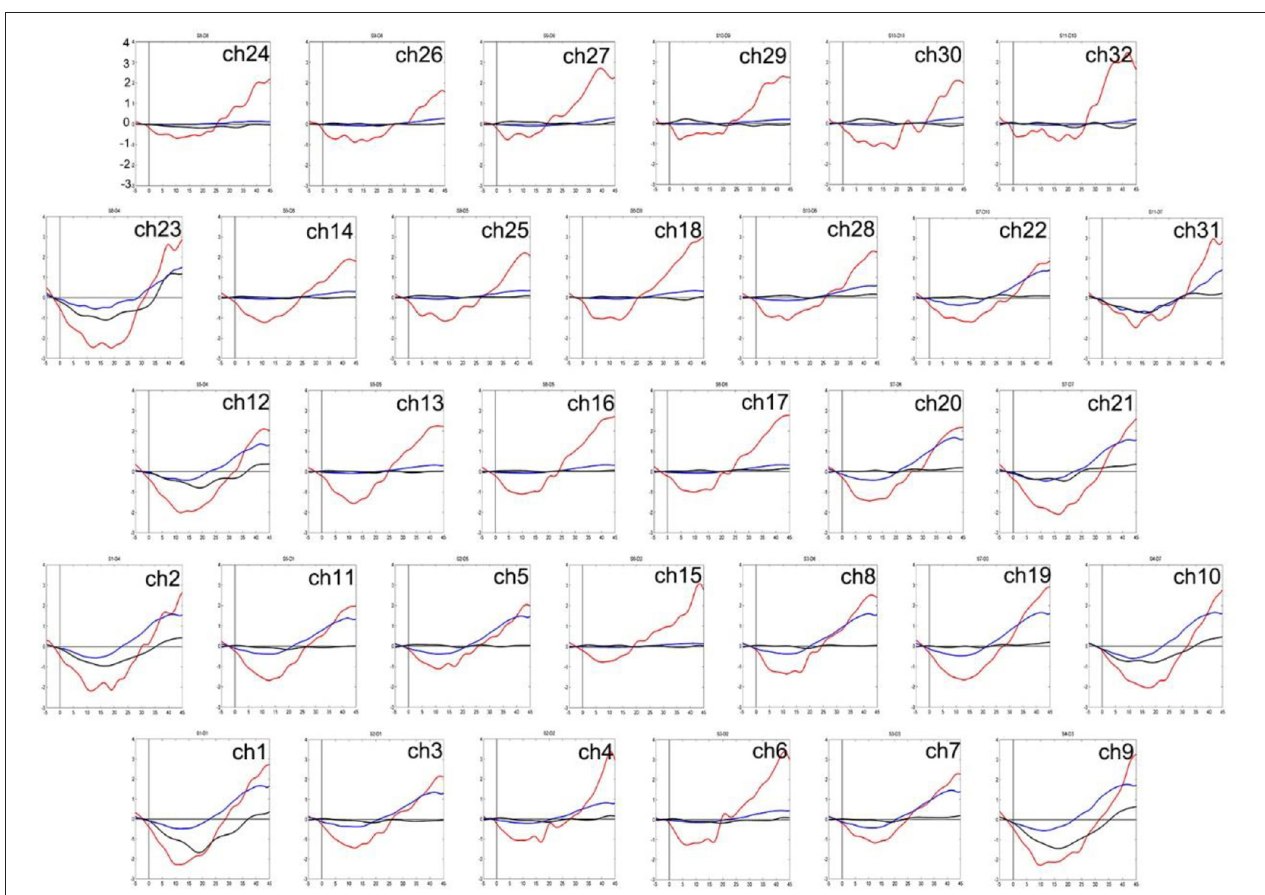
Frontiers in Psychiatry |